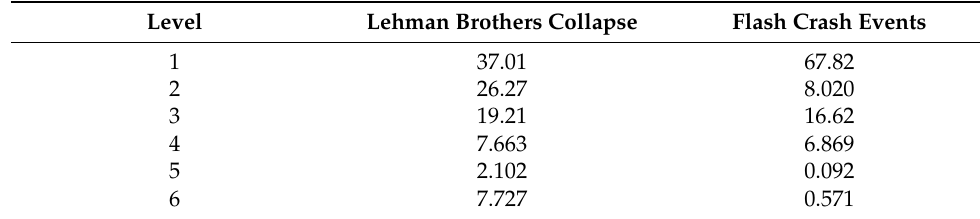
Table 13. Total energy for MCD stock market data.